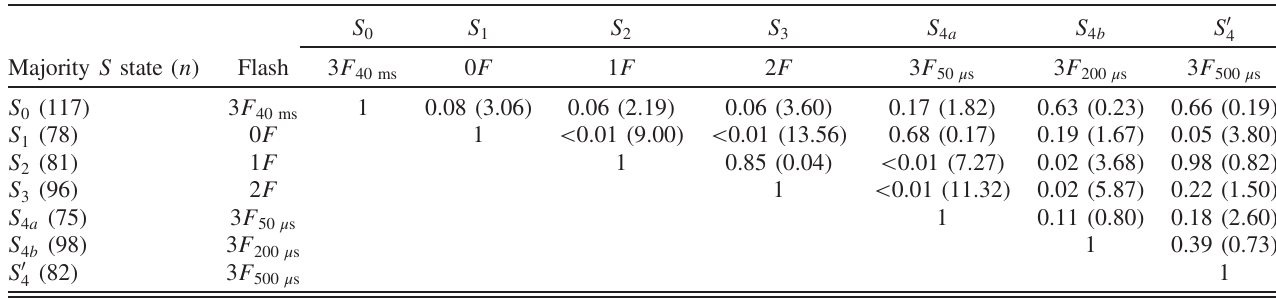
TABLE III. p and F -statistic values from ANOVA for state-to-state comparisons between the state in the row and the state in the column for data sets 1 – 4 combined. p values are based on the first moments over the range 6.485 – 6.495 keV. The number of “ samples ” (i.e., threads) is shown in parentheses for each state. These values are broken down by beam time in Table S2 [5]. See Table II for additional comparisons between the states based on the number of x-ray pulses per state per beam time and Figs. 2(c) and 3(c) for dot plots of all first moments used for p -value calculations. Values for the F -statistic are given in parentheses. An analysis of data set 5 is shown in Fig. S4